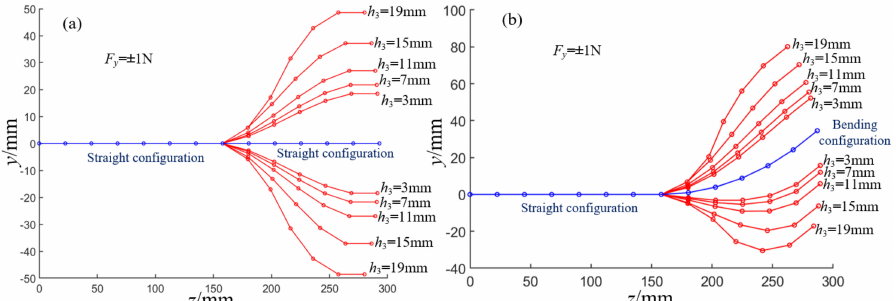
Figure 17. The equilibrium conformations of the distal segment under different h 3 . ( a ) The equilibrium conformations of the distal segment in initial configuration. ( b ) The equilibrium conformations of the distal segment in bending configuration.